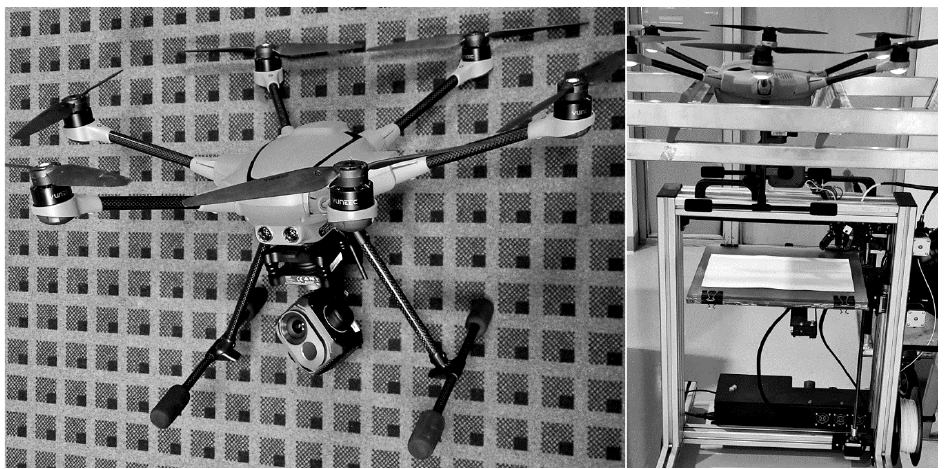
Figure 2. H520 drone with the E10T camera. The drone is attached to the radiometric calibration over the heated bed of the Omni3d Factory 1.0 printer.